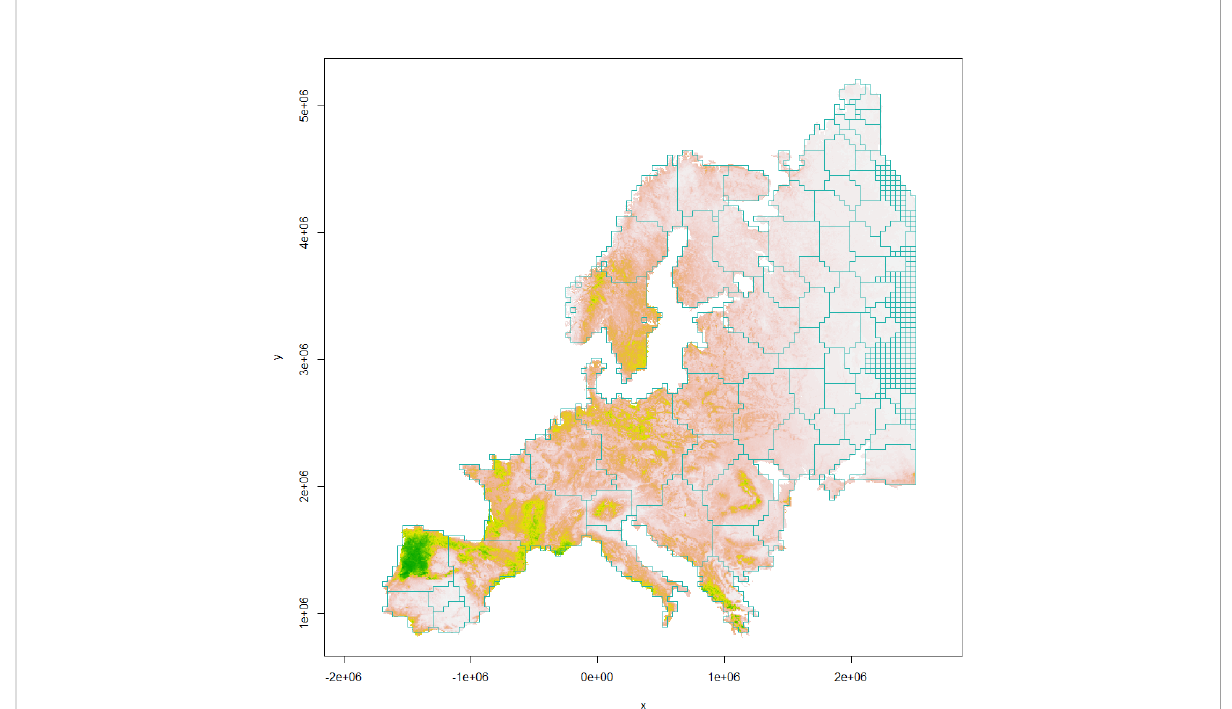
FIGURE 2 The boundaries of European gray wolf habitat clusters (light seagreen polygons) delineated from the Leiden algorithm are shown against the habitat suitability index map (colors from gray to green indicating less to more suitable